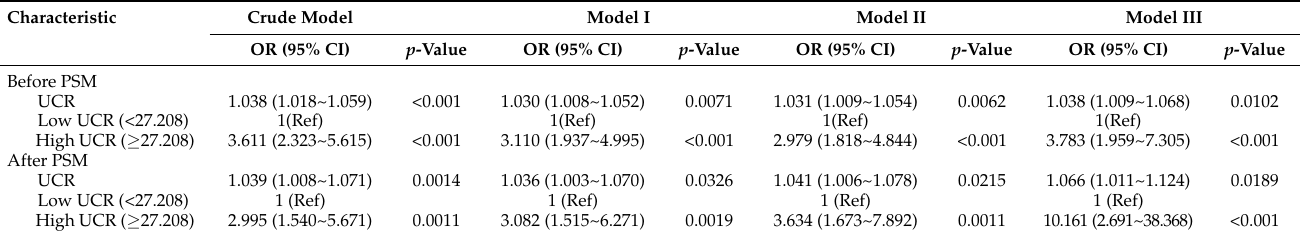
Table 3. Multivariable logistic regression analyses for in-hospital mortality in patients with non- traumatic subarachnoid